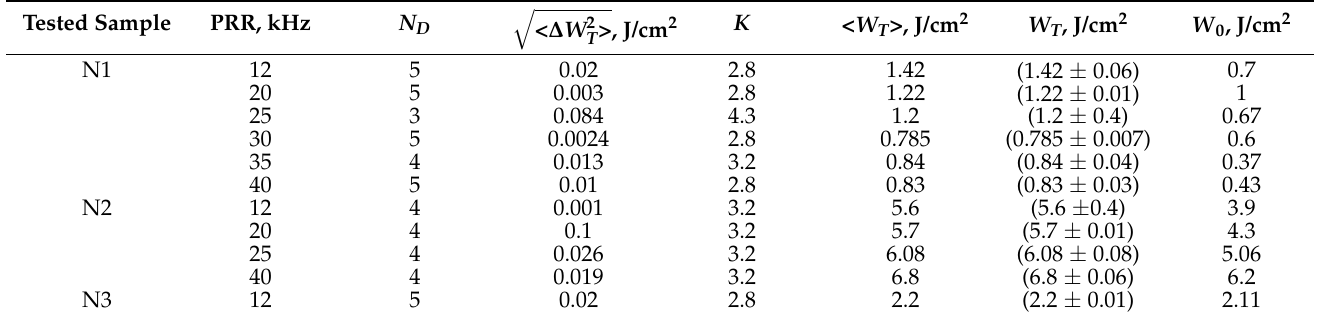
(cid:113) < W 2 > , the K coefficient of the error dispersion at the confidence Table 2. The average error T probability of P T = 0.95, the average LIDT fluence < W T >, the 0-probability LIDT fluence W 0 for the sample N2 elements, and OChC elements with damaged site number N D at varied PRR.